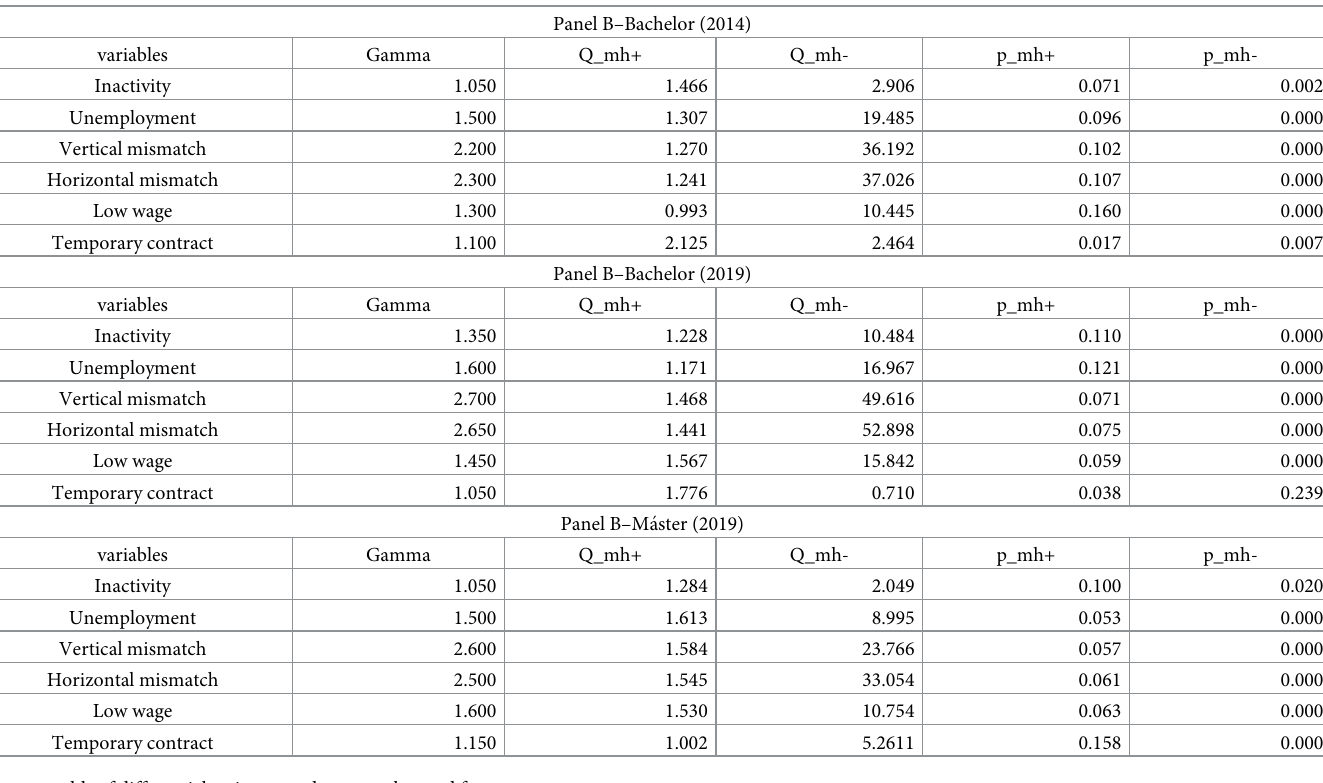
Table 8. Rosenbaum bounds for ATET in the presence of unobserved heterogeneity.